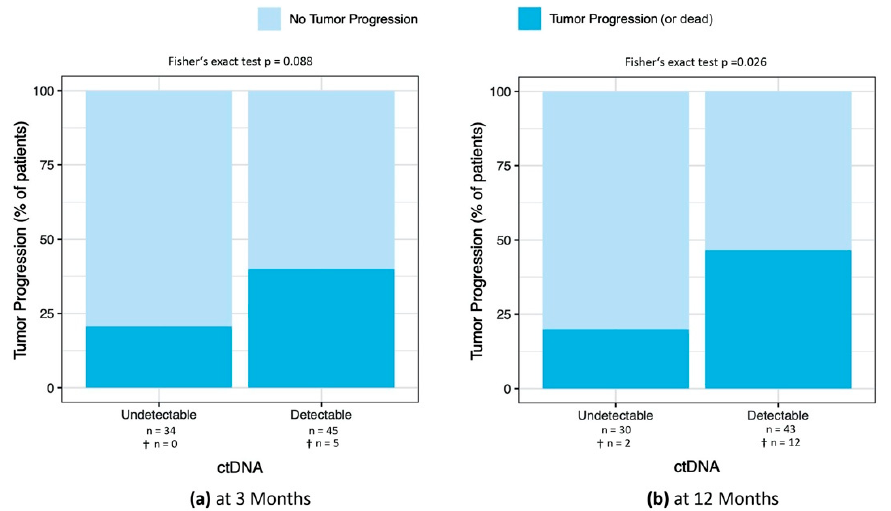
Figure 4. ( a ) Percentage of patients with tumor progression at 3 months after ctDNA sample collec- tion in patients with detectable and undetectable ctDNA. ( b ) Percentage of patients with tumor pro- gression at 12 months in patients with detectable and undetectable ctDNA. p -value was determined with Fisher’s exact test. At the time of data analysis, the follow-up results at 12 months for 6 patients were not yet available. †, number of patients who died.